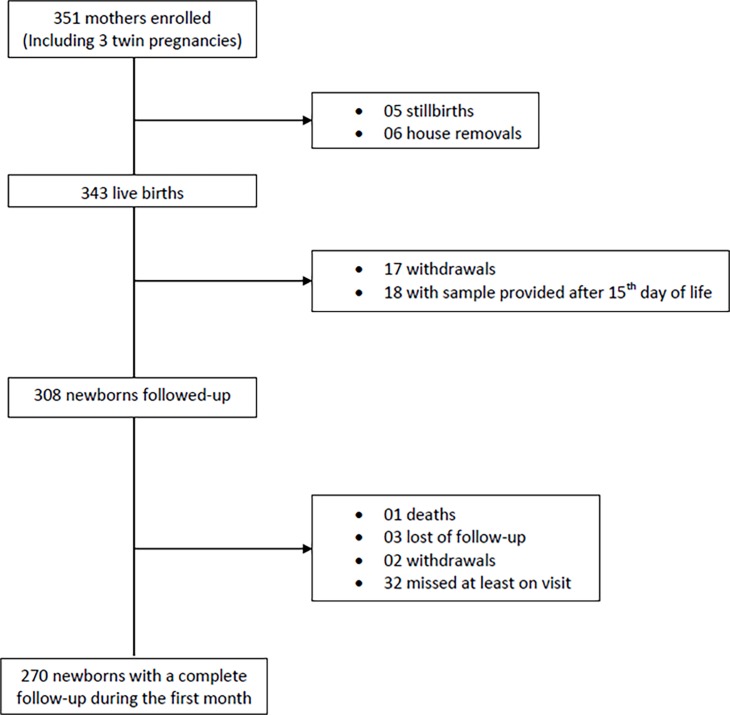
Flow-chart of the study participants.